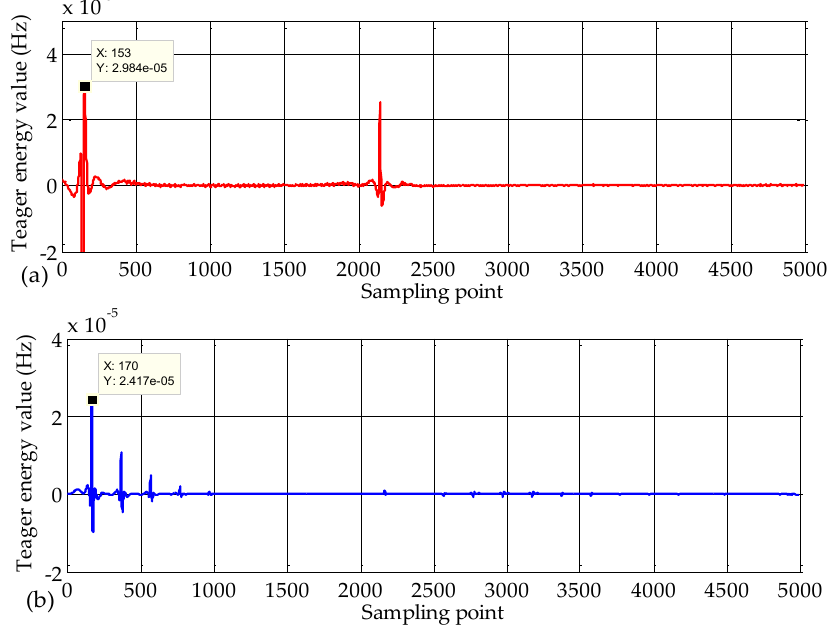
Figure 9. The instantaneous mode 1 energy spectrum: ( a ) At terminal M and ( b ) At terminal N.